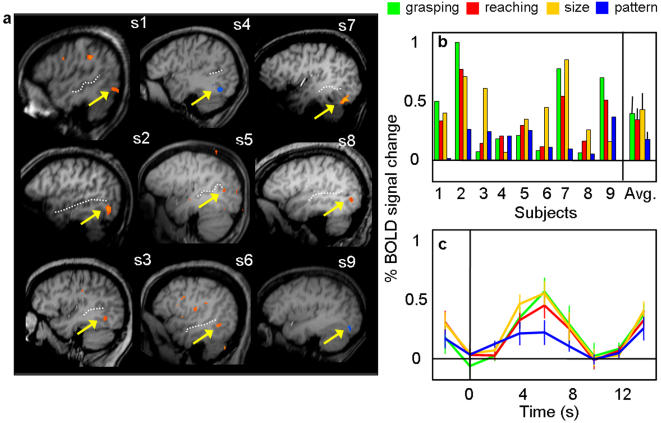
Individual activation maps and percent BOLD signal change (% BSC) in the left lateral occipitotemporal (LO) cortex for Experiment 1.
a) The exact position of the left LO localized by comparing size discrimination versus pattern discrimination is shown in the clearest sagittal slice for each of the nine subjects. In each subject, LO was below the posterior end of the inferior temporal sulcus (ITS, dotted line). Note that in 2 of the 9 subjects, LO was activated by the reverse contrast of pattern versus size discrimination (reported in blue). b) Bar graphs display the magnitude of peak activation in %BSC in each experimental condition at the level of single subject and group average (the rightmost bars). c) Line graphs indicate the event‐related averaged time courses in % BSC with time zero indicating visual stimuli onset. Both magnitude of peak activation and event‐related averaged time courses showed that size discrimination was higher than pattern discrimination and moreover that grasping did not differ from reaching.